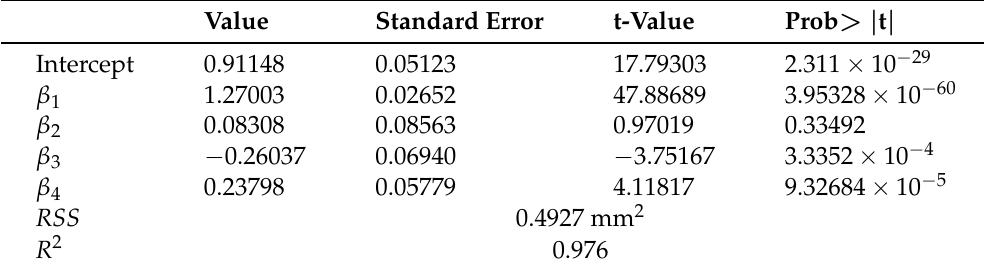
Table 4. Results of multiple regression analysis